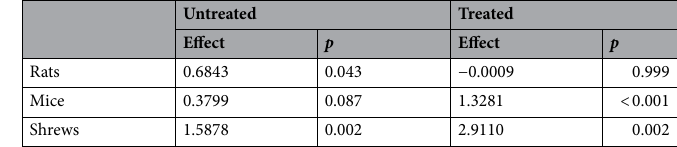
Table 2. Estimates of the effect of rodenticide treatment on the number of tracking plates marked per night by rats, mice or shrews at three study sites on the island of Rum between 2010 and 2013. A positive value indicates an increase in activity between early summer and late summer. Rodenticide treatment, site and year were included as fixed effects in the model (see Table